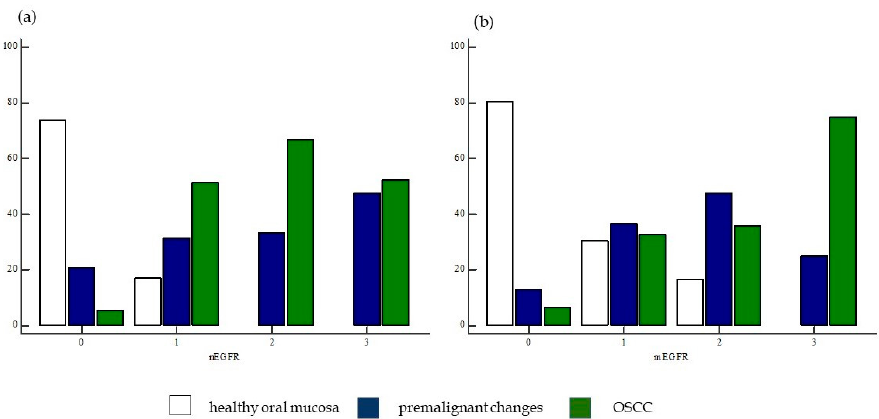
Figure 9. Expression of nEGFR and mEGFR between the studied groups of subjects. Comparisons of the expression of ( a ) nEGFR and ( b ) mEGFR between the groups of subjects analyzed showed statistical significance ( χ 2 = 85.96, p < 0.0001; χ 2 = 70.40, p < 0.0001). Legend: nEGFR—nuclear EGFR; mEGFR—membrane EGFR; 0—negative, 1—weak expression, 2—moderate expression, 3—strong expression.